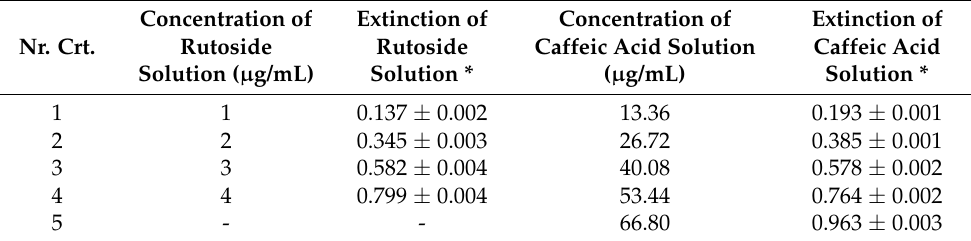
Table 1. Variation in extinction according to the concentration of rutoside solution ( µ g/mL) and variation according to the concentration of caffeic acid solution ( µ